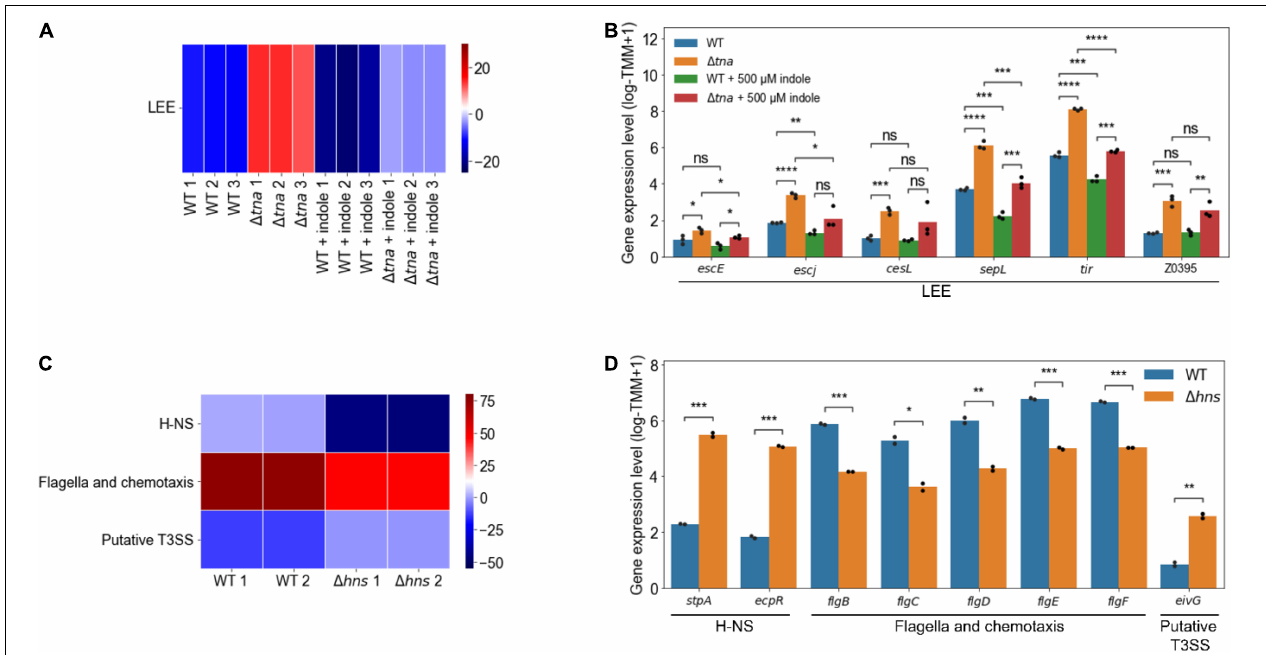
FIGURE 4 | The changed activities of the modulons obtained from the transcriptome data of EHEC EDL933 and its isogenic mutants. Heatmap for the changed activities of the modulons obtained from the transcriptome data of the WT and (cid:49) tna in the presence or absence of 500 µ M indole (A) , and the WT and (cid:49) hns (C) . The numbers on the bottom labels indicate a distinct single biological replicate. Red and blue represent the high and low activity of the modulon, respectively. WT, EDL933; (cid:49) tna, tna deletion mutant; (cid:49) hns, hns deletion mutant. The bar plots for the expression levels of the element genes of the modulons obtained from the transcriptome data of the WT and (cid:49) tna in the presence or absence of 500 µ M indole (B) , and the WT and (cid:49) hns (D) . The modulon names of the element genes are denoted below the plots. The distinct colors of the bars represent the strains and the experimental conditions as indicated in the plots. Each dot on the bars represents a single biological replicate. Statistical significance was determined by the Student’s t -test (ns, not significant; * P < 0.05; ** P < 10 − 2 ; *** P < 10 − 3 ; **** P < 10 − 4